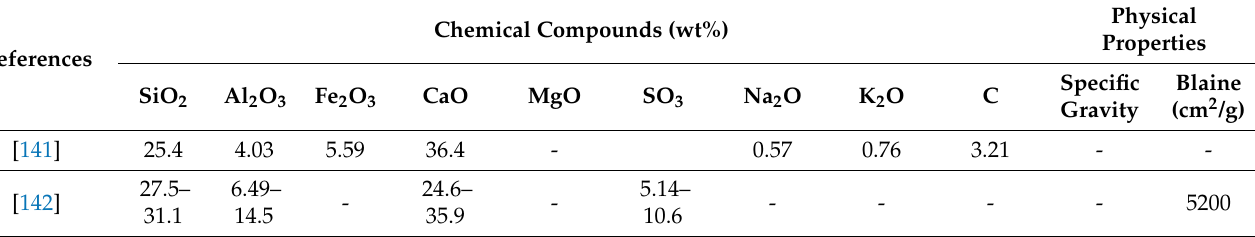
Table 6. Chemical composition of